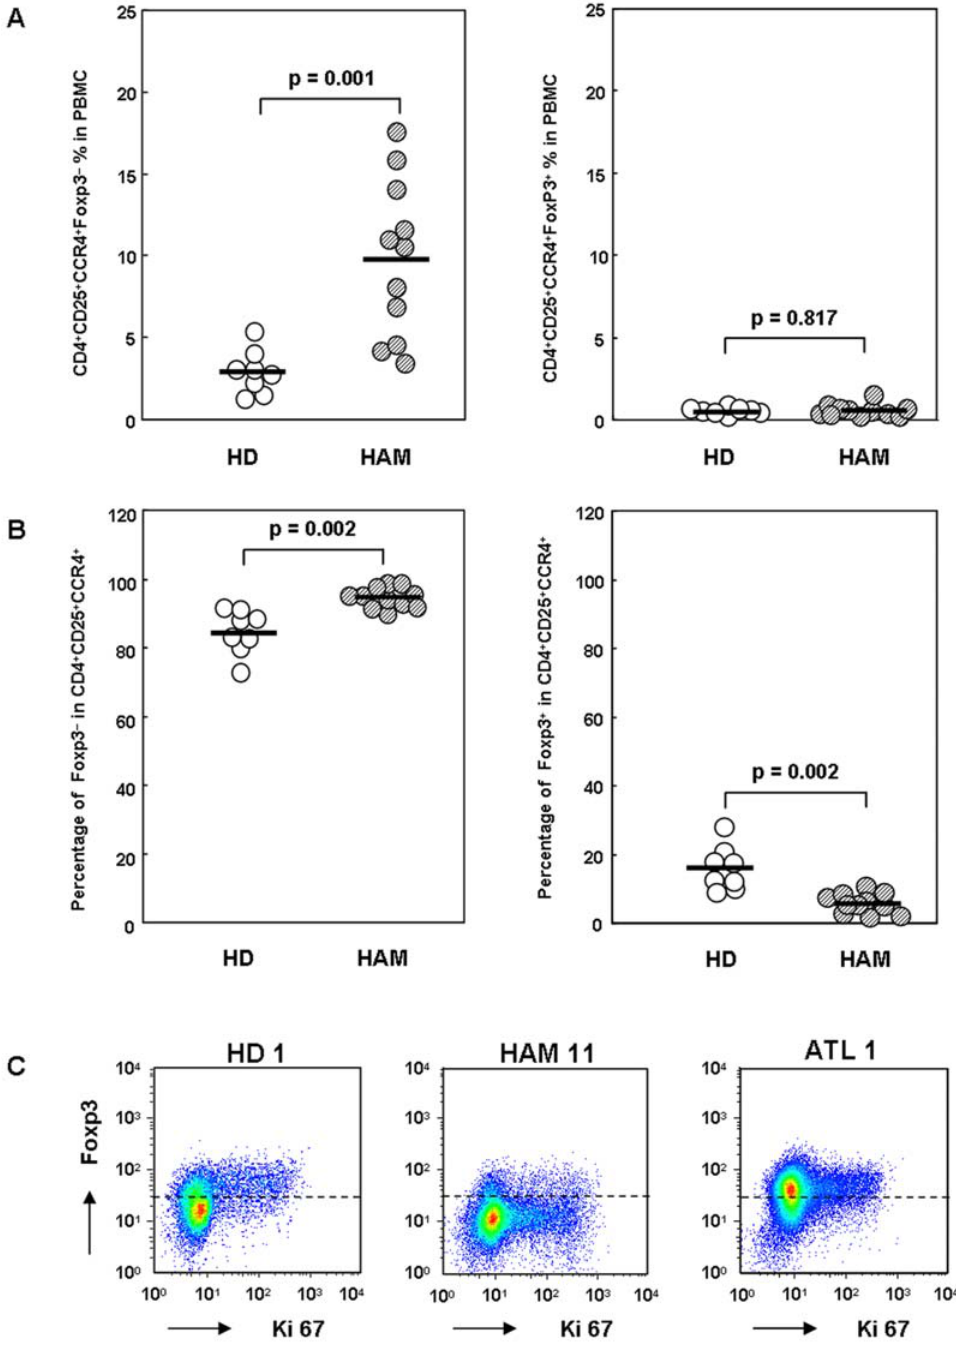
Figure 3. The Foxp3-negative CD4 + CD25 + CCR4 + T cells are higher in HAM/TSP patients than in healthy donors. A. Percentage of the CD4 + CD25 + CCR4 + Foxp3 2 or CD4 + CD25 + CCR4 + Foxp3 + T cells in the total PBMCs in HD and HAM/TSP patients. PBMCs from 8 HD and 11 HAM/TSP patients were stained for CD4, CD25, CCR4, and intracellular Foxp3. The percentage of CD4 + CD25 + CCR4 + Foxp3 2 (left panel) or CD4 + CD25 + CCR4 + Foxp3 + (right panel) T cells to the total PBMCs was calculated by FACS analysis. The horizontal bar indicates the mean value of each group. An unpaired Student’s t test was used for statistical analysis. B. Percentage of the Foxp3 2 or Foxp3 + population in CD4 + CD25 + CCR4 + T cells. PBMCs from 8 HDs and 11 HAM/TSP patients were stained for CD4, CD25, CCR4, and intracellular Foxp3. Then, the percentage of the Foxp3 2 (left panel) or Foxp3 + (right panel) population in CD4 + CD25 + CCR4 + T cells was calculated. The horizontal bar indicates the mean value of each group. The percentage of the Foxp3 2 population in CD4 + CD25 + CCR4 + T cells was significantly higher in the HAM/TSP patients than in the HDs (p=0.002, unpaired Student’s t test), and the percentage of the Foxp3 + population in the CD4 + CD25 + CCR4 + T cells was significantly lower in the HAM/TSP patients than in the HDs (p=0.002, unpaired Student’s t test). C. Foxp3 and Ki67 expression in CD4 + CD25 + CCR4 + T cells from HD 1, HAM 11, and ATL 1. CD4 + T cells were negatively separated by magnetic beads and stained for CCR4, CD25, and intracellular Foxp3 and Ki67. CD25 + CCR4 + cells were gated, and the expression levels of Ki67 and Foxp3 were plotted.